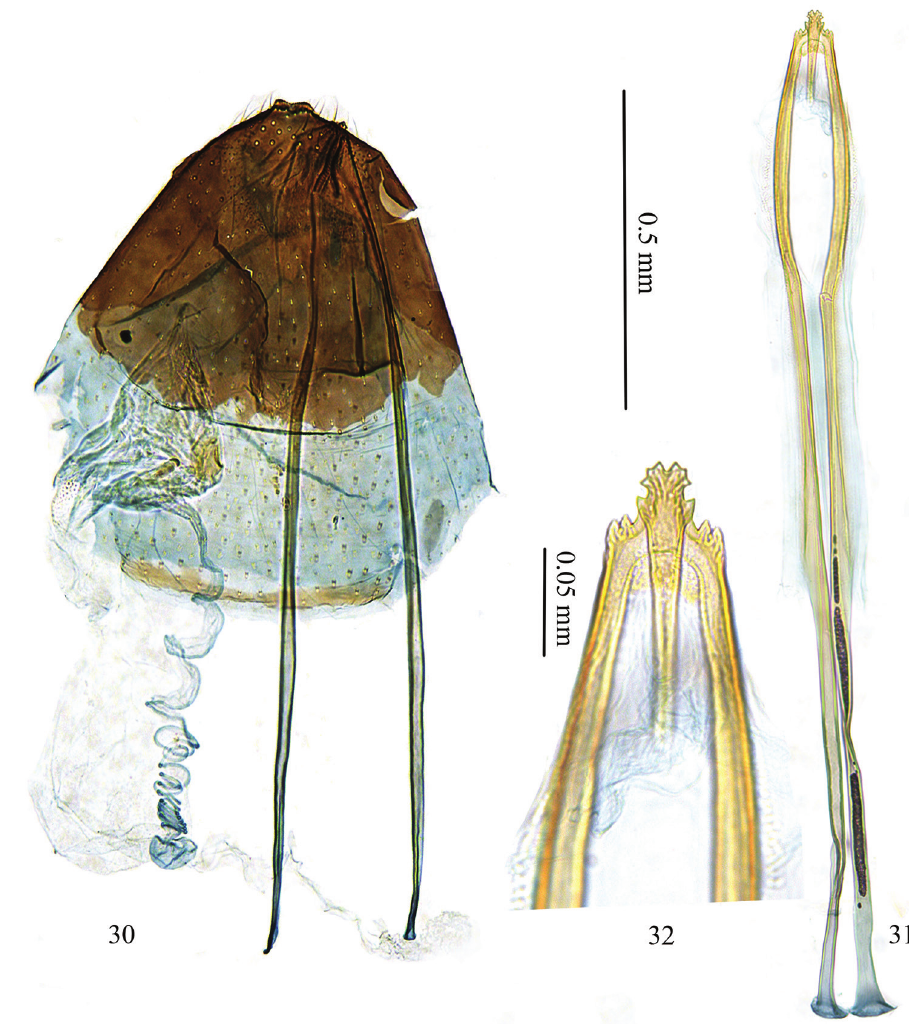
Figures 30–32. Female genitalia of Antispila uenoi . 30 female genitalia, SDNU.LIU0043 31 posterior apophyses and ovipositor tip, same slide as 30 32 detail of ovipositor tip, same slide as 30. truncated distally; M stalked with Rs , to termen near apex, M from lower corner 1 3+4 2+3 of distal end of cell; CuA from distal 1/7 of lower margin of cell; A to beyond middle 1+2 of dorsum. Hindwing with Sc to beyond middle of costa, R+M ending in 4 branches: Rs to costa, M to dorsum near apex, M and M to dorsum; Cu to middle of dorsum; 1 2 3 A weak. Male with one long frenulum, female bearing two shorter frenular bristles. 1+2 Male genitalia (Figs 16–25). Tuba analis developed. Uncus bar-shaped, with two pa- pillae bearing two short setae each at middle, bearing one long and a few shorter setae laterally (Fig. 22). Vinculum shorter than phallus, rounded on anterior margin.